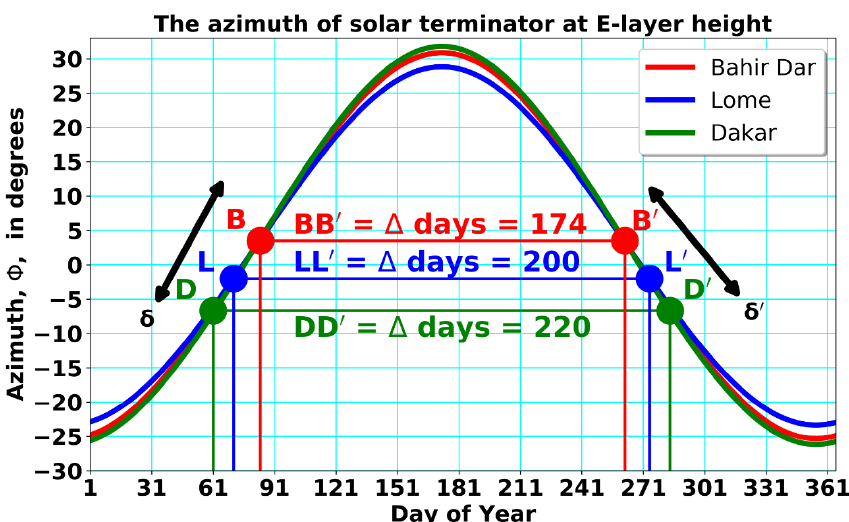
Figure 7. Seasonal variation of the azimuth of the day-night terminator at GNSS stations in Dakar, Lomé and Bahir Dar (cf. Figure 4). The indicated dots are days of azimuth coincidence with geomag- netic declination (horizontal lines) at these three selected stations.